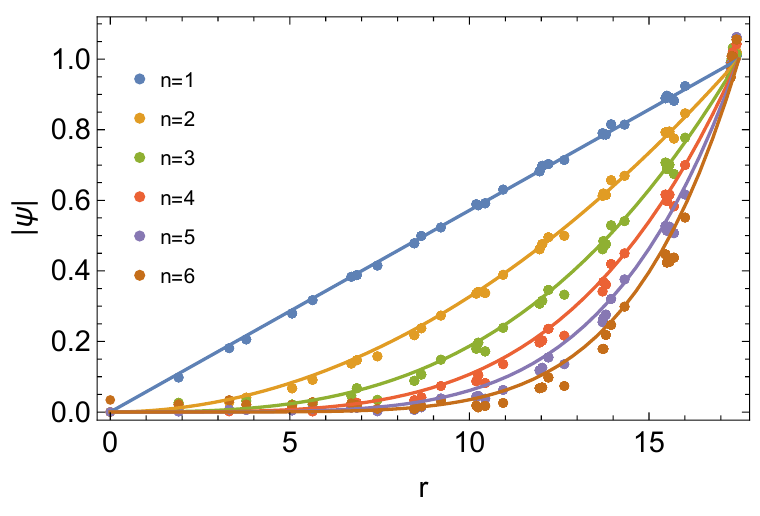
Figure 3: | ψ | as a function of radial distance, r , for the first six anti-holomorphic modes for N = 331 = C vortices. Dots are numerical data scaled so that the average 10 value of | ψ | on the outer circle of vortices ( r ≈ 17 ) is 1, solid lines show r n , scaled to be equal to one at the outer circle. No other fitting is